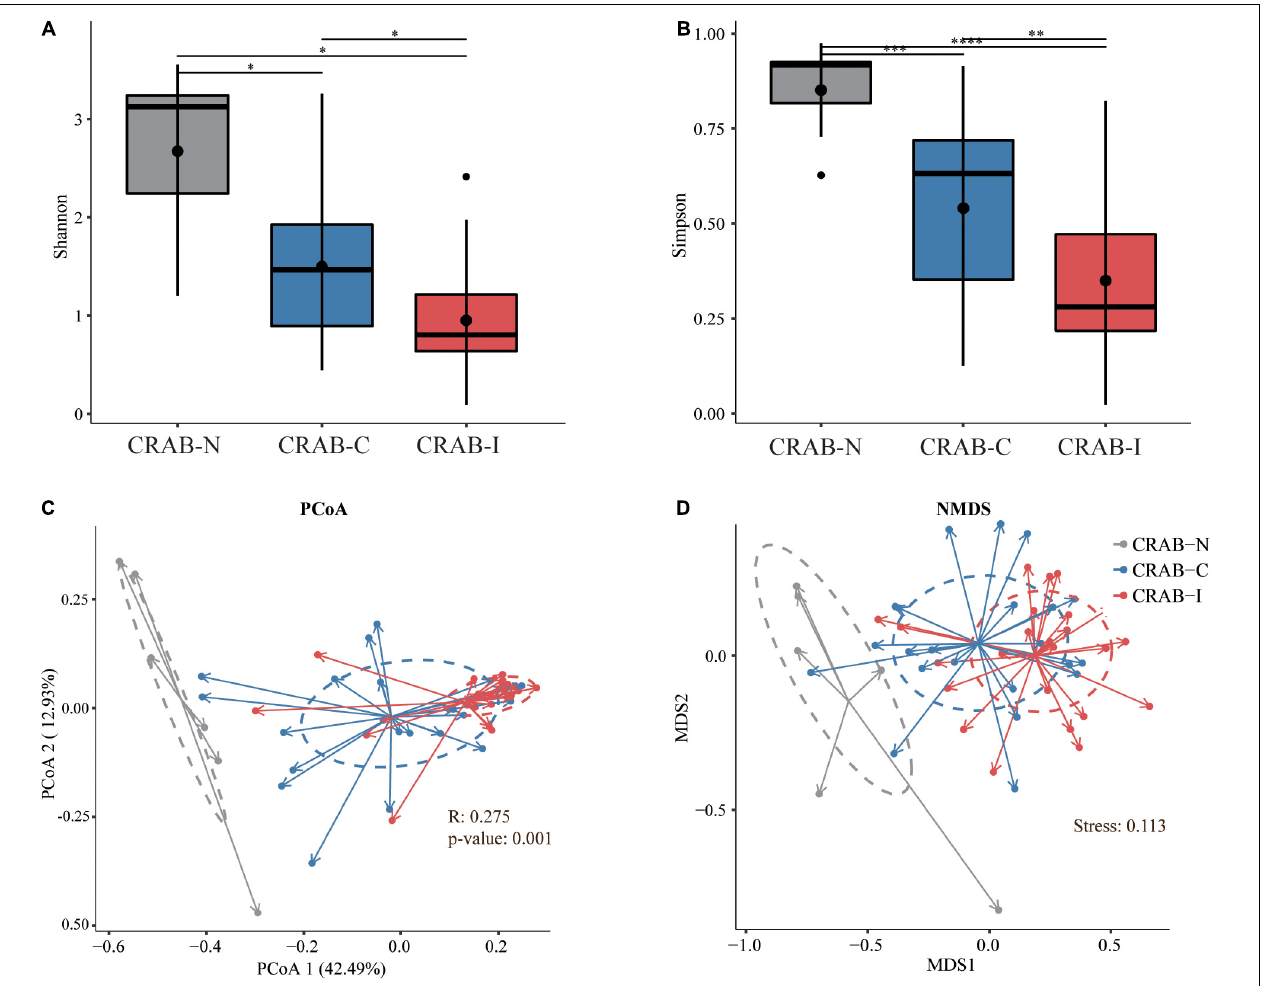
FIGURE 2 | Phylogenetic diversity comparison of lower respiratory tract (LRT) microbiota in LRT microbiota of patients with neither VAP nor CRAB LRT colonization (CRAB-N), LRT microbiota of patients with CRAB colonization but without VAP (CRAB-C), and LRT microbiota of patients who developed CRAB VAP (CRAB-I) patients. (A) Box plots depict microbiota diversity differences according to the Shannon index among three group. (B) Box plots depict microbiota diversity differences according to the Gini Simpson index among three group. The upper and lower ranges of the box represent the 75 and 25% quartiles, respectively. (C) The X-axis shows PCo 1 and the Y-axis PCo 2 form Bray-Curtis distances for β -diversity. The changes per patient are visualized in as dashed lines dark red for CRAB-I, in blue for CRAB-C and in gray for CRAB-N. Logistic regression analysis showed that the change of PCo1 was significantly lower in patients who developed pneumonia ( P = 0.001). (D) The X-axis shows MDS 1 and the Y-axis MDS 2 form Bray-Curtis distances for β -diversity (Stress = 0.113). The changes per patient are visualized in as dashed lines dark red for CRAB-I, in blue for CRAB-C and in gray for CRAB-N. Significant differences are indicated by ∗ P < 0.05, ∗∗ P < 0.01, ∗∗∗ P < 0.001, and ∗∗∗∗ P <